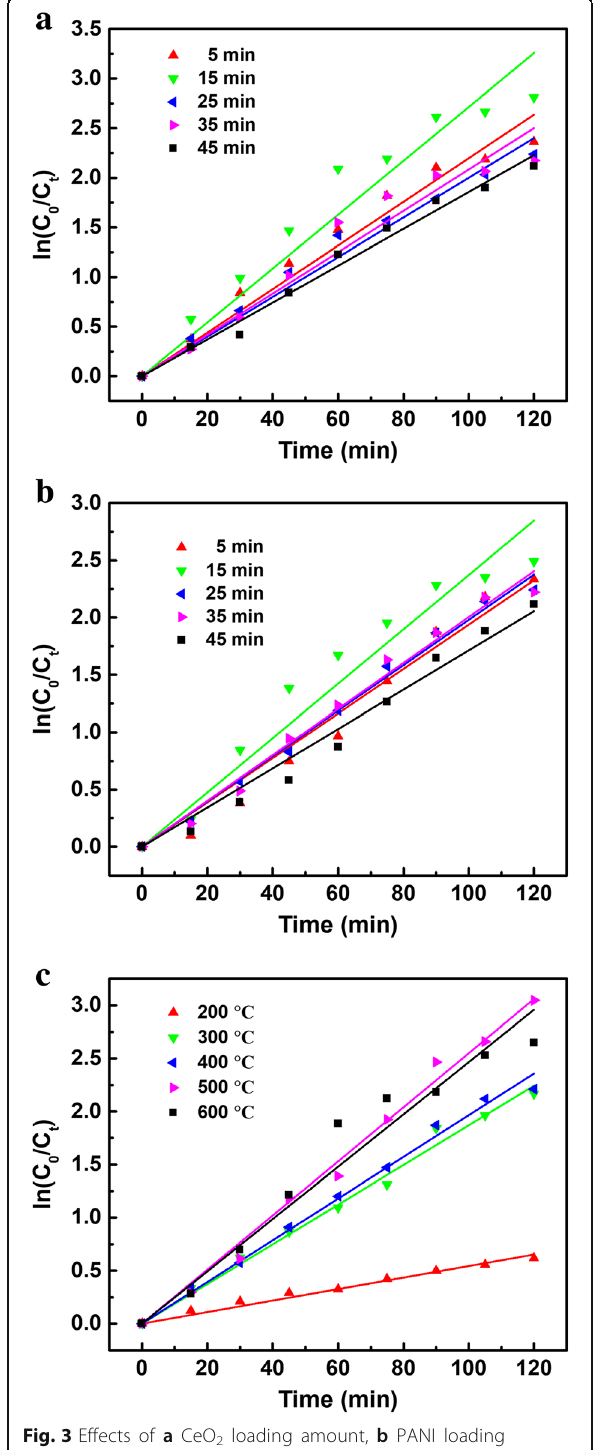
Fig. 3 Effects of a CeO 2 loading amount, b PANI loading amount, and c annealing temperature. The geometric surface area of TiO 2 electrode was 2.0 × 2.5 cm 2 . Initial concentration